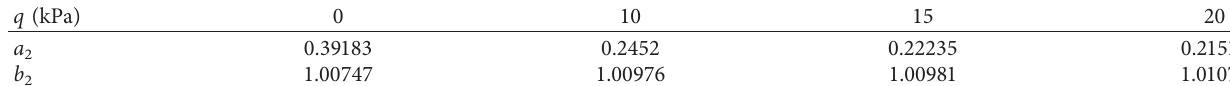
Table 9: Parameter values of a